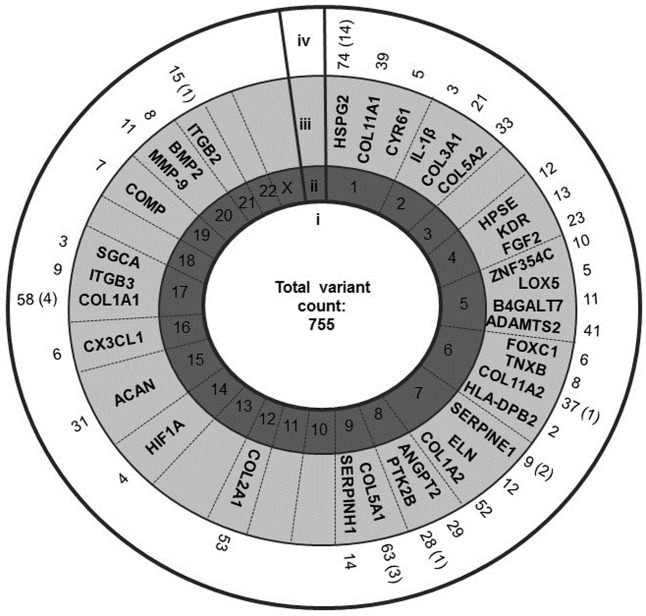
Distribution of variants identified by whole exome sequencing within genes proposed as plausible candidates for Achilles tendinopathy using the BioOntological Relationship Graph database.Schematic diagram demonstrating the number and distribution of variants identified by WES mapping to the 35 genes identified as plausible candidates for Achilles tendinopathy using BORG. (i) Total number of variants identified mapping to the 35 BORG candidate genes. (ii) The autosomes numbered from 1–22, and the X gonosome. (iii) Names of BORG identified candidate genes. (iv) Total number of variants identified mapping to BORG identified genes candidates with number of variants meeting the allele frequency difference threshold in parentheses.